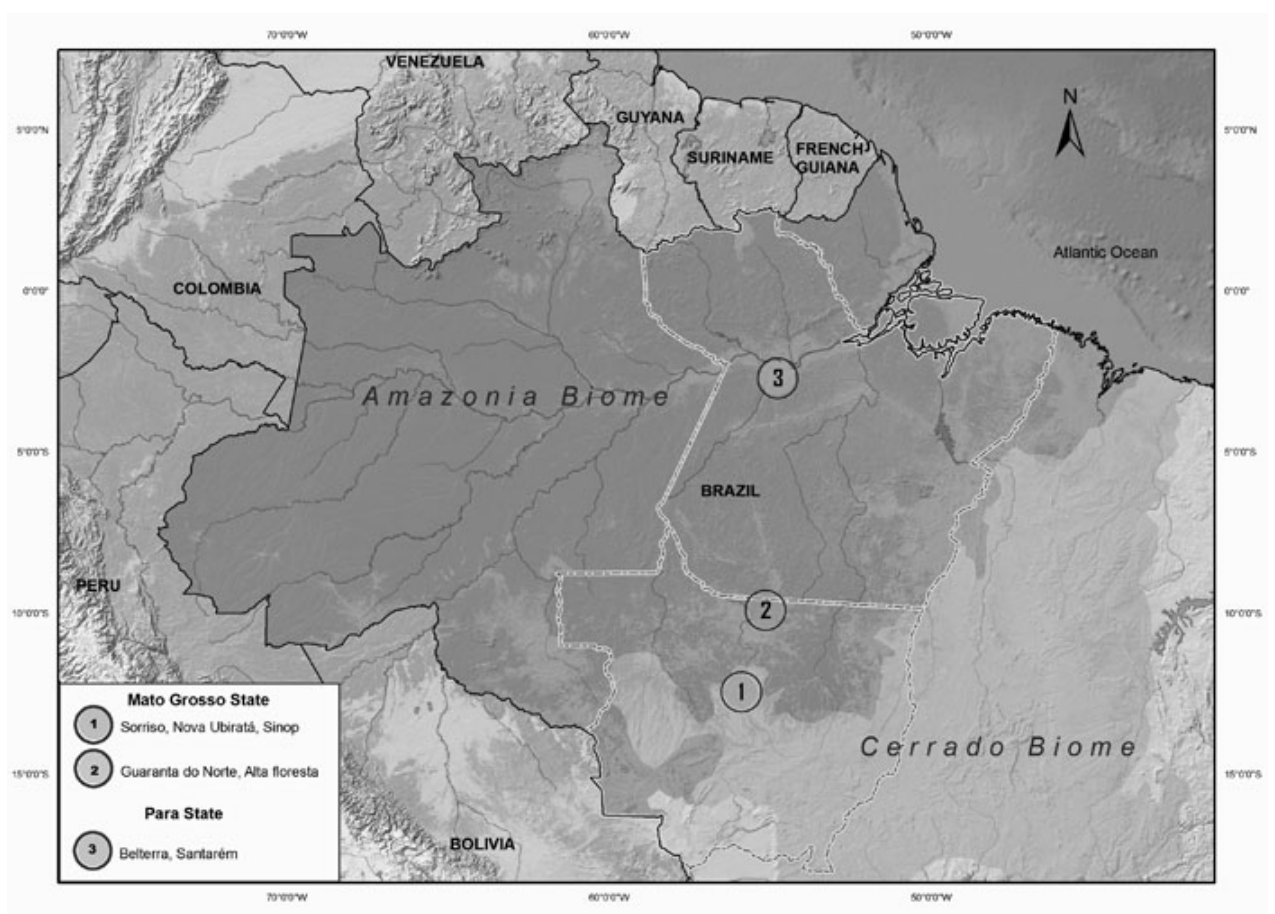
Fig. 1 . Location of study areas. Source: Base map from Natural Earth